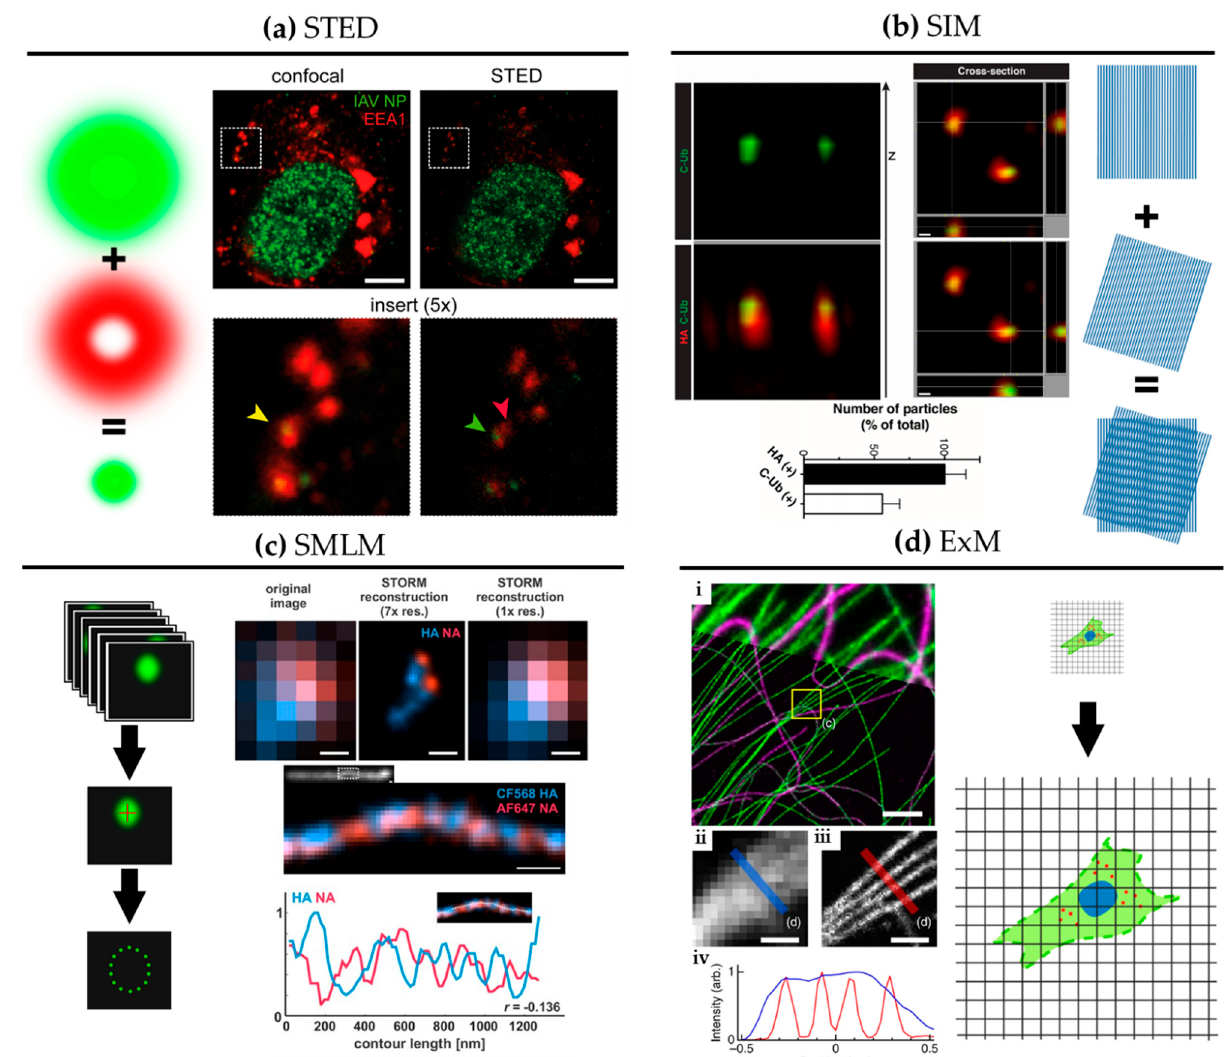
Figure 2. Super ‐ resolution microscopy for the study of influenza virus replication. ( a ) STED . Confocal (left) and STED (right) images of a dendritic cell 4 hours post ‐ infection with influenza virus vRNP (green) and the early endosomal marker EEA1 (red). Scale bar: 5 μ m. Adapted from [28]. ( b ) SIM. 3D SIM z ‐ stack and cross ‐ section images of purified influenza viruses labelled for hemagglutinin (HA) (red) alongside immuno ‐ labelling of the C ‐ terminus of ubiquitin (C ‐ Ub) (green). Bottom: quantification of HA and C ‐ Ub colocalization. Scale bar: 100 nm. Adapted from [30]. ( c ) SMLM. Top: diffraction ‐ limited image and d STORM reconstructions at ~30 nm resolution of influenza viruses labelled for NA (red) and HA (blue). Bottom: d STORM reconstructions of a filamentous virion labelled for HA and NA at ~30 nm resolution with corresponding intensity profile. HA and NA are shown to exclude one another. Scale bar: 200 nm. Adapted from [39]. ( d ) ExM. BS ‐ C ‐ 1 cell labelled for tyrosinated tubulin (green) and de ‐ tyrosinated tubulin (magenta). (i): Comparison of ExM image (bottom) with corresponding pre ‐ expansion image (top). Scale bars: 2 μ m. Insert, pre ‐ (ii) and post ‐ expansion (iii) with corresponding intensity profiles (iv). Scale bars: 500 nm. Adapted from [40].